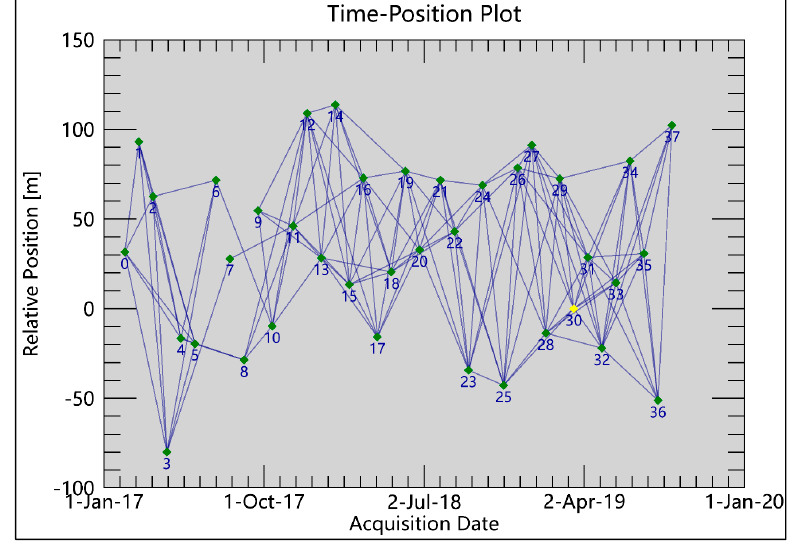
Figure 4. Spatial–temporal distribution of interferogram formation. Green dots and blue lines represent images and interferometric pairs, respectively. Yellow dot is the master images used for the co-registration.